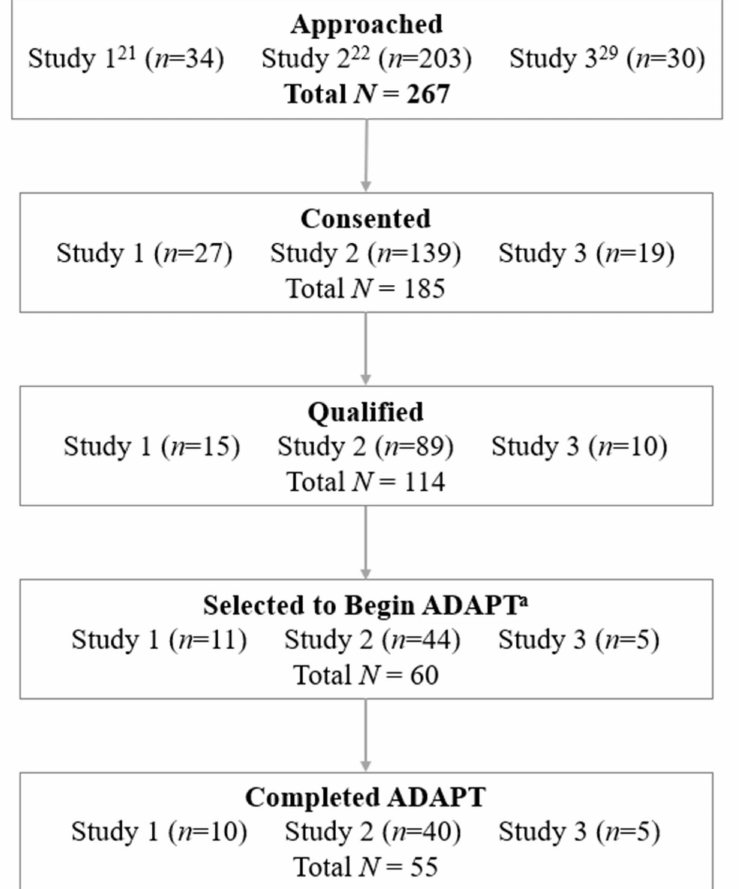
Figure 1. Participant flow. Potentially eligible patients were approached to participate. Consenting participants were assessed for study eligibility. Of those, a portion of qualifying participants were then selected to begin ADAPT. Of the 60 total participants selected to begin ADAPT, 57 began the program and 55 completed the ADAPT protocol. For more detail on eligibility criteria and exclusion of participants, please see the original studies [21,22,29]. Note : a All participants were offered ADAPT (Study 1) or were randomized to ADAPT (Studies 2 & 3). ADAPT = Aim to Decrease Anxiety and Pain